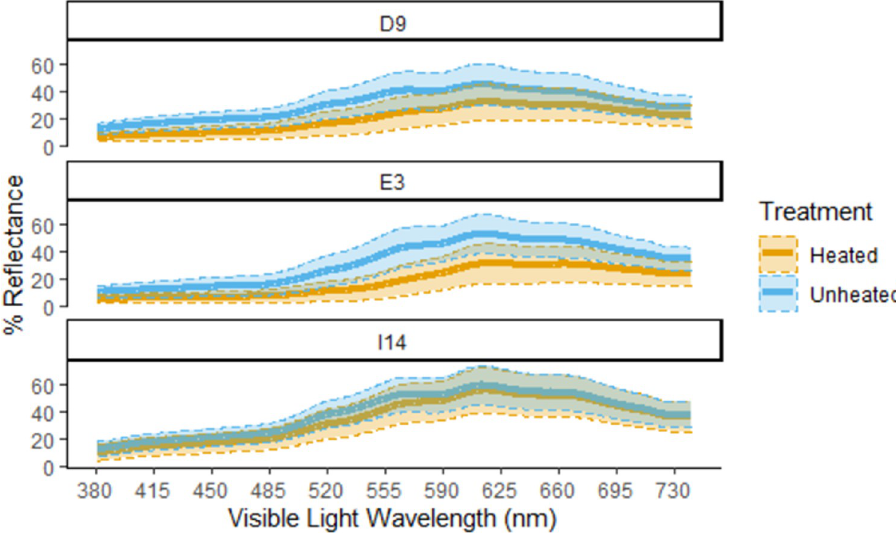
Fig 5. Percent reflectance by level of treatment across sources. Mean percent reflectance (bold lines) results by silcrete source for unheated vs heat-treated silcrete. The shaded blue and yellow areas associated with each line indicate the standard deviation of observed percent reflectance